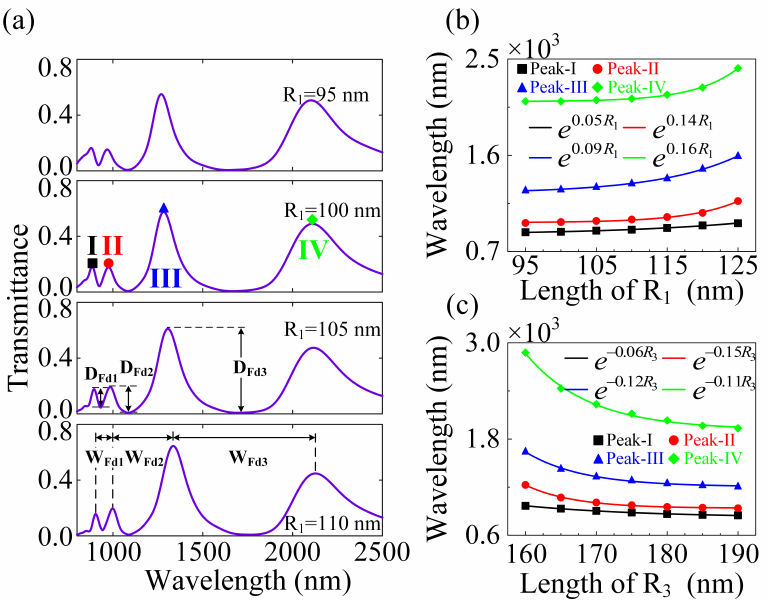
Figure 5. Triple-FRs-based plasmonic sensing with in-plane mirror asymmetry σ z . ( a ) The transmit- tance spectra for the hybrid RMM with different inner radii ( R 1 ) of the CSA unit cells, where the incident light is polarized along the Z-axis. ( b ) The resonance center wavelengths of the four peaks of the triple FRs in the hybrid RMM as four different exponential increase functions of the inner radius ( R 1 ) of the CSA unit cells. ( c ) The resonance center wavelengths of the four peaks of the triple FRs in the hybrid RMM as four different exponential decrease functions of the outer radius ( R 3 ) of the CRA unit cells. The other parameters are the same as Figure